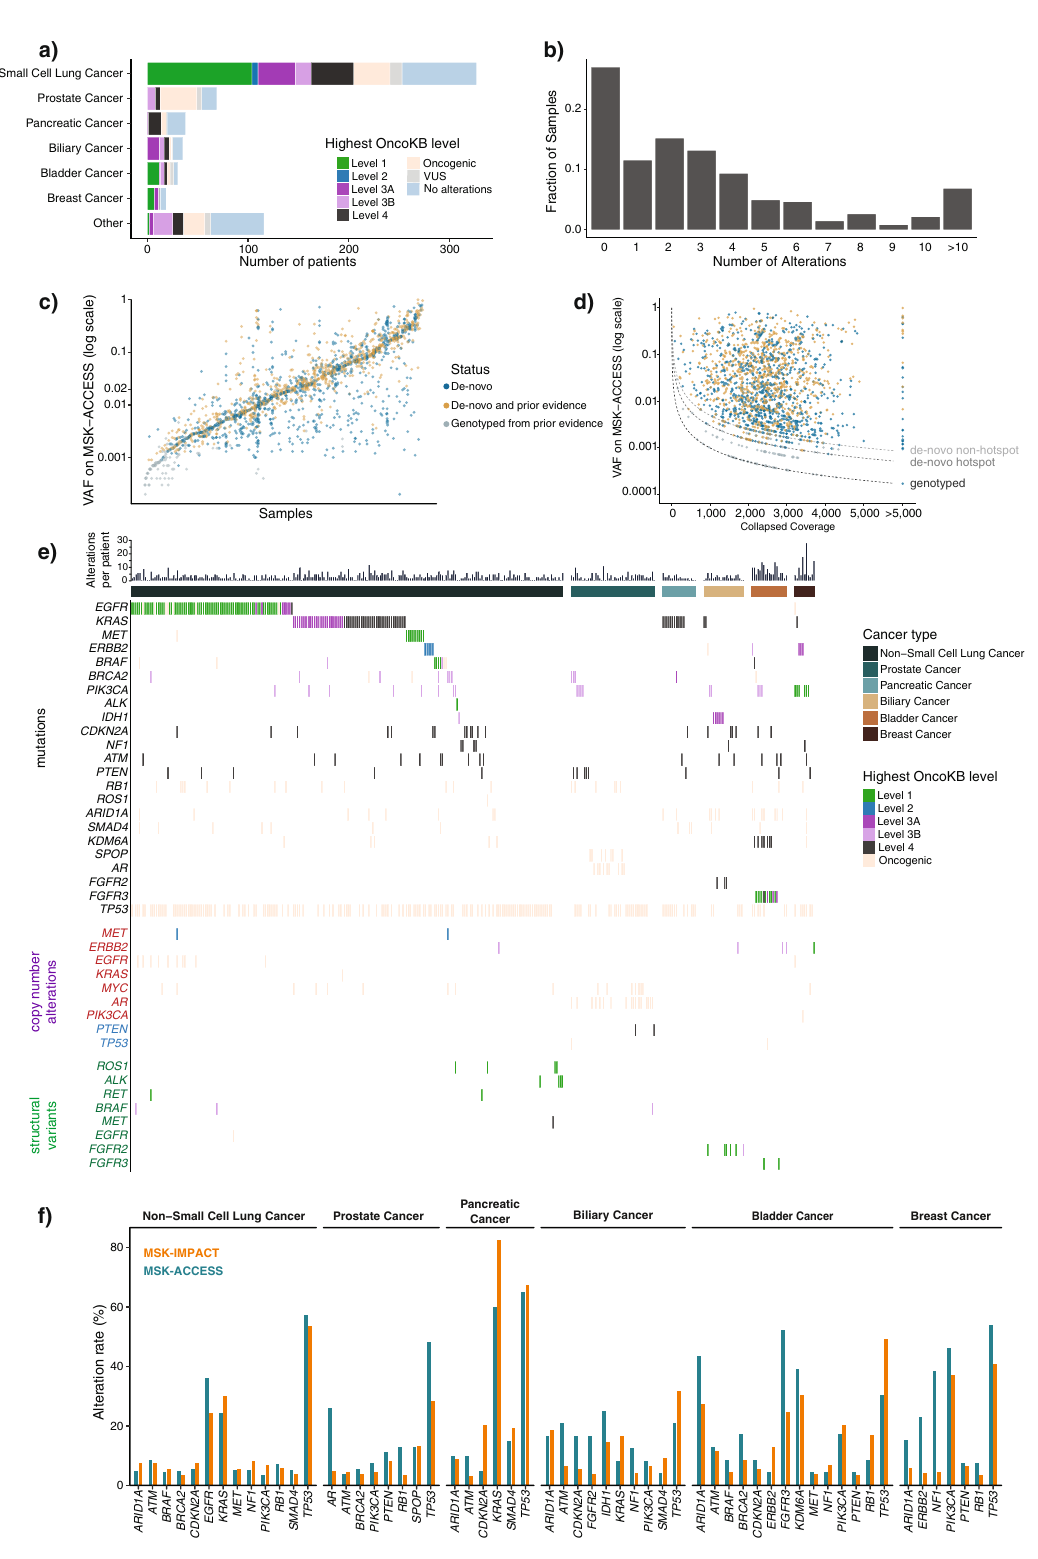
of mutation calling between MSK-IMPACT and MSK-ACCESS where available. For a consistent comparison analysis across all patients, we selected plasma mutations from the fi rst sample sequenced by MSK-ACCESS for each patient for whom multiple time points were analyzed, and used the union of mutations across all tissue samples for each patient sequenced on MSK- IMPACT. Of the 617 patients tested with MSK-ACCESS, 383 also